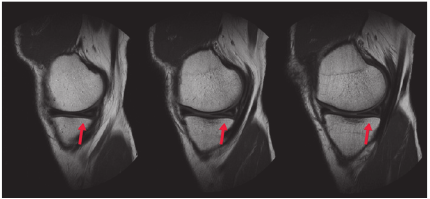
Figure4:SagittalProtonDensity(PD)magneticresonanceimaging showing the chondral flap (arrow). It appears flap-like and is attached at its anterior aspect.